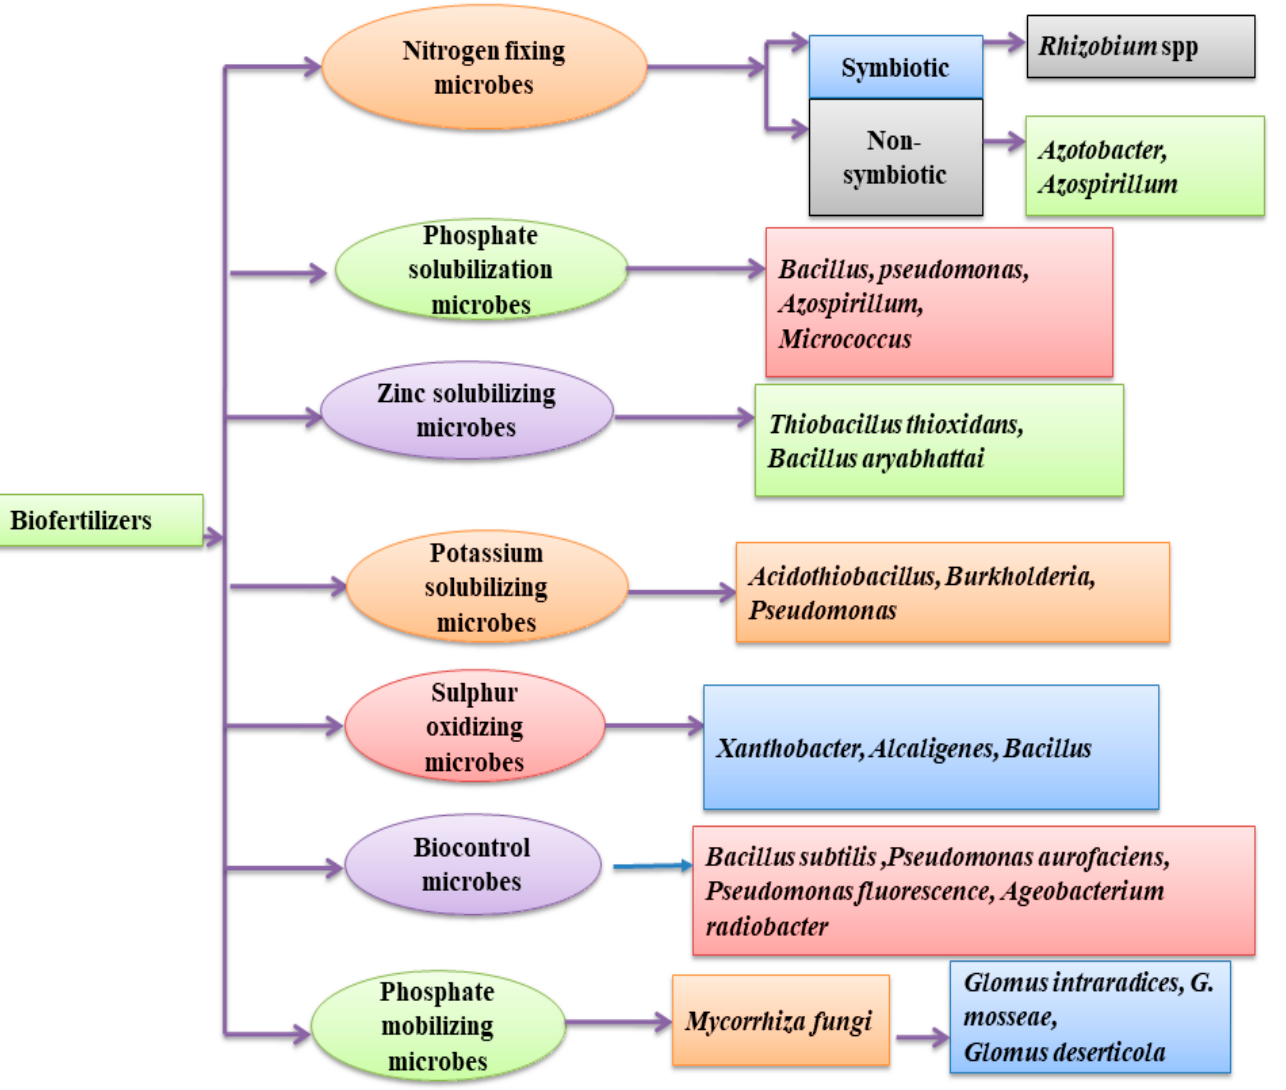
Figure 2. Schematic diagram of categories of microorganisms used as biofertilizers. Nodule formation is enhanced by the low availability of nitrogen, but microorganisms that produce an enzyme 1-aminocyclopropane-1-carboxylate (ACC) deaminase, have the potential to degrade 1-aminocyclopropane-1-carboxylate before its conversion to ethy- lene [29,30] and may also enhance the formation of a nodule. Such formation is part of a common strategy developed by leguminous plants and Rhizobiaceae bacteria to decrease the concentration of oxygen to which the nitrogenase is exposed due to the inhibitory effect of oxygen on nitrogenase activity. However, there are other nitrogen-fixing microorganisms, such as those of the Acetobacter genus, able to fix nitrogen even under aerobic